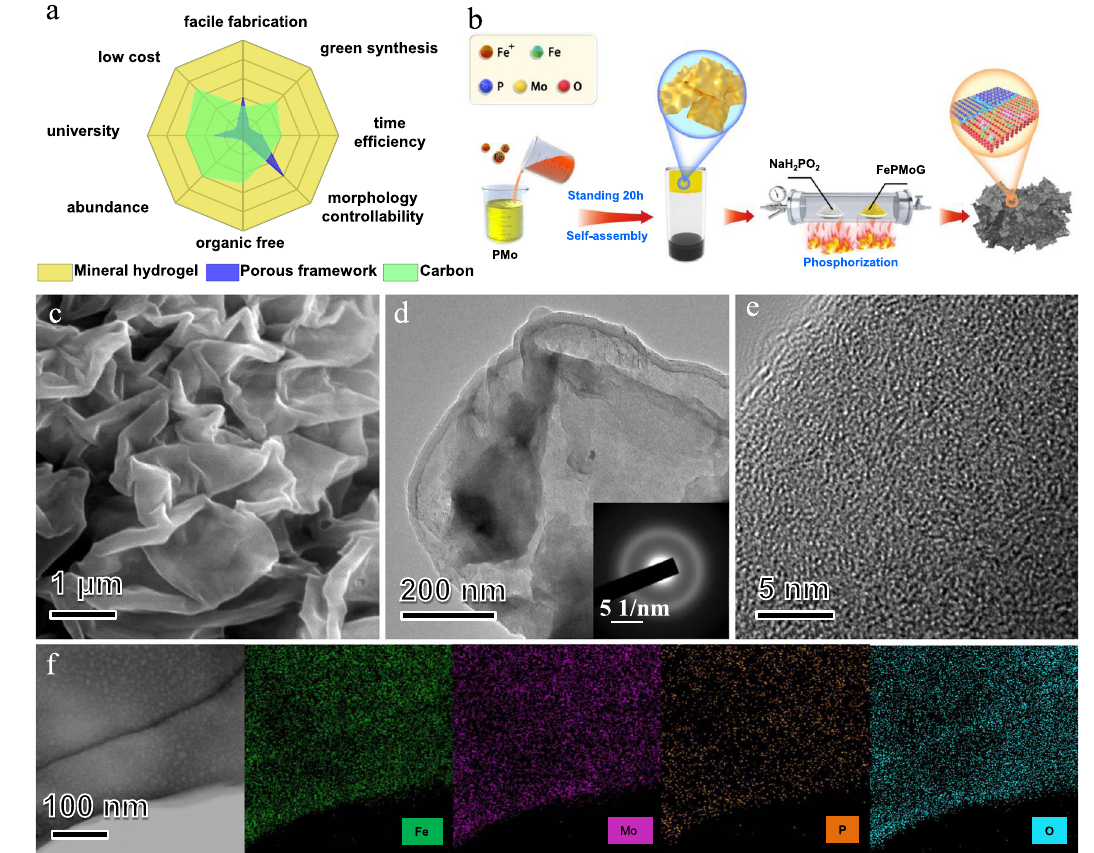
Fig. 1 | Conceptual design and microstructural characterisation of the as- prepared FePMoG and Fe/SAs@Mo-based-HNSs eletrocatalyst. a General char- acteristicscomparisonofthecommonsubstrateprecursorsforSACs(moredetails presented in Table S1); b schematic of synthesis of the Fe/SAs@Mo-based-HNSs